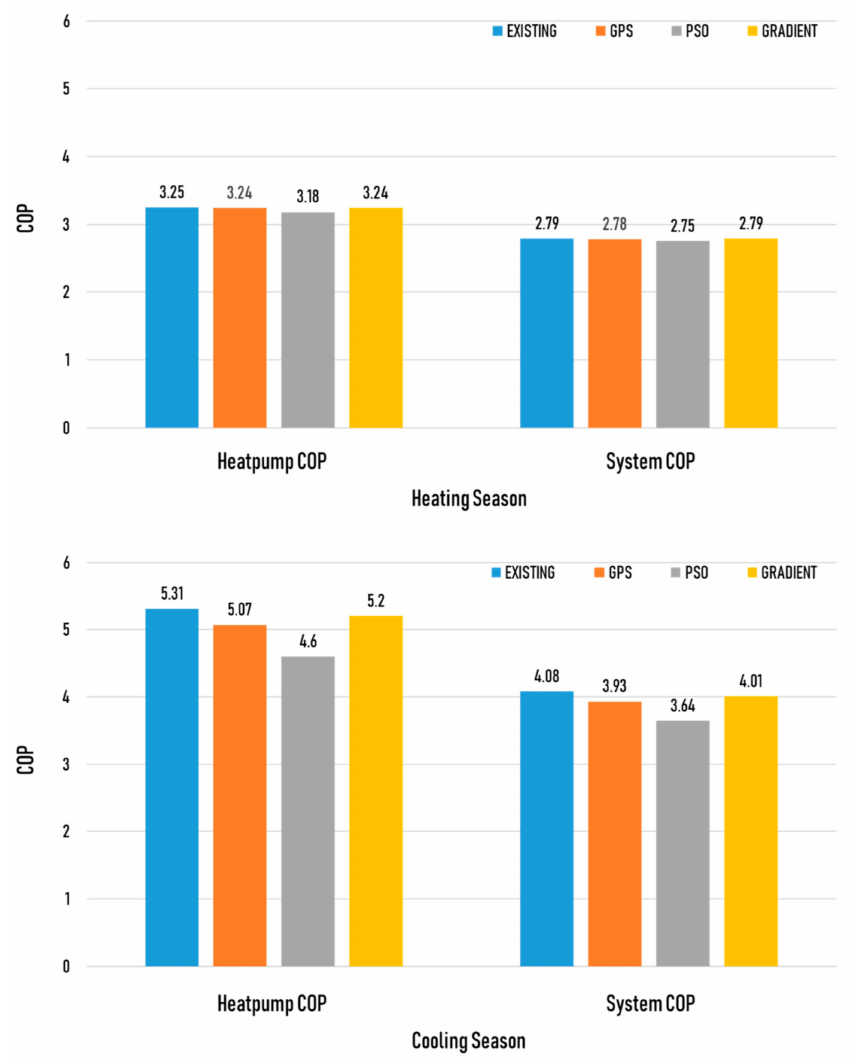
Figure 12. Heat pump and system coe ffi cient of performance